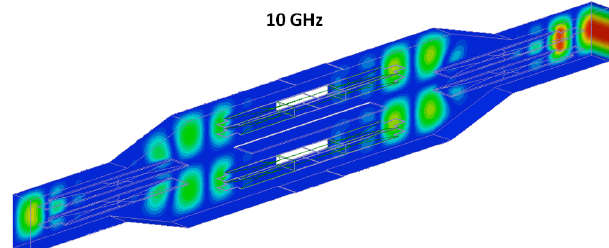
Figure 11: E-field distribution in the SPC at 10